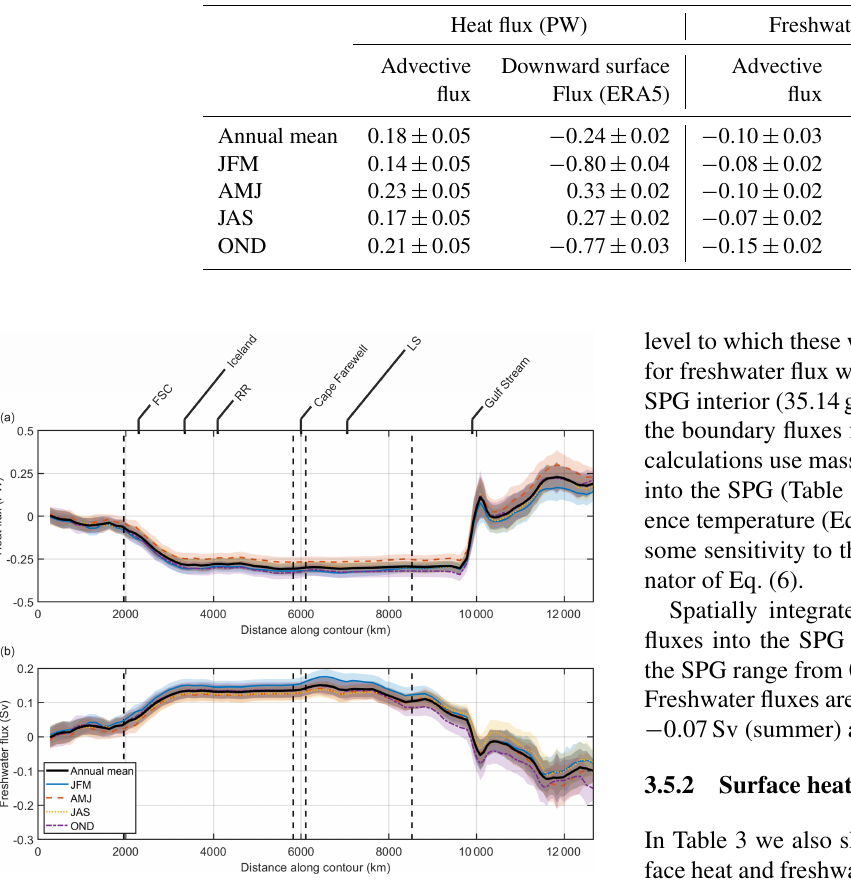
Figure 10. Cumulative heat (PW) and fresh water (Sv) fluxes into the SPG between surface and seabed for (a) heat and (b) freshwater, using corrected velocities for sub-1000m currents. Key locations around the boundary are labelled as in Fig. 3, and vertical dashed lines denote OSNAP